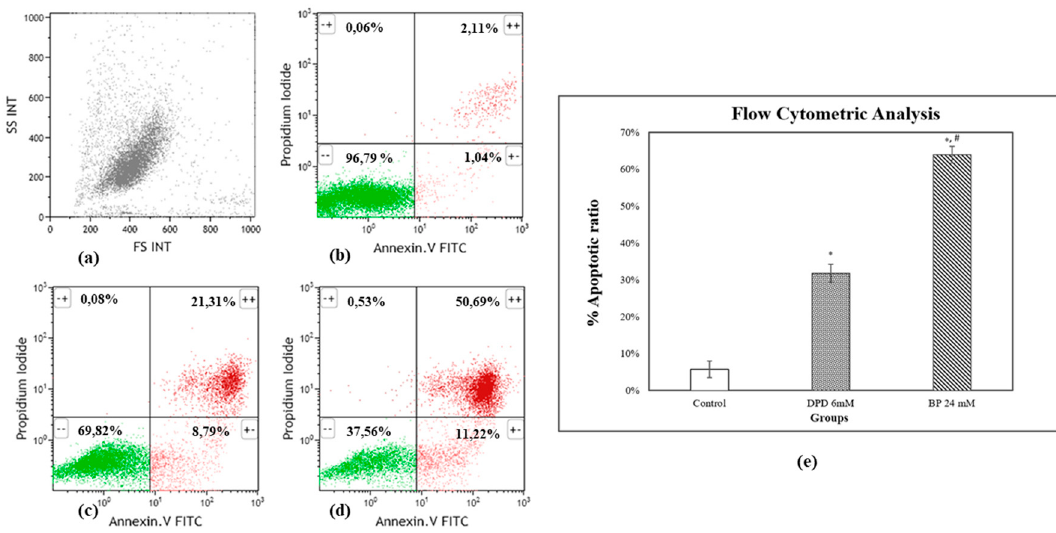
Figure 2. ( a ) Flow cytometric analyses of HL-60 cells Morphological analysis ( b ) Diagram of Annexin V-FITC/PI of control cells. ( c ) Diagram of Annexin V-FITC/PI DPD-treated HL-60 cells. ( d ) Diagram of Annexin V-FITC/PI BP-treated HL-60 cells. ( e ) Apoptotic cell ratios among the groups.